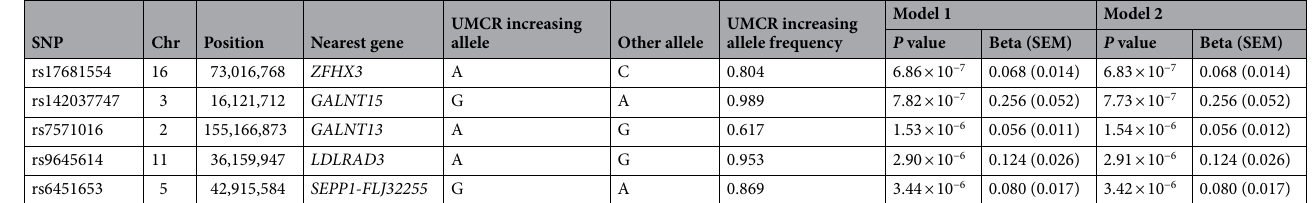
Table 2. Association of genetic loci with log UMCR in a Taiwan Han Chinese population. Model 1 was adjusted for age, sex and the first ten principal components of ancestry. Model 2 was additionally adjusted